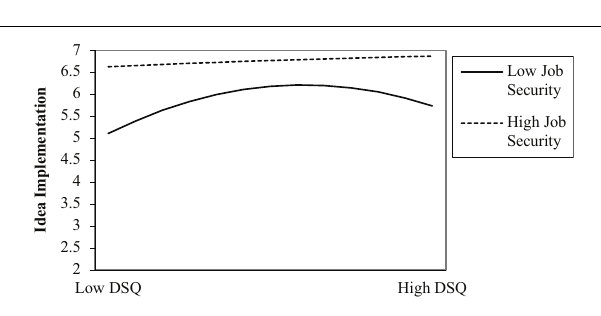
FIGURE 5 | Relationship between dissatisfaction with the status quo (DSQ) and idea implementation as a function of job